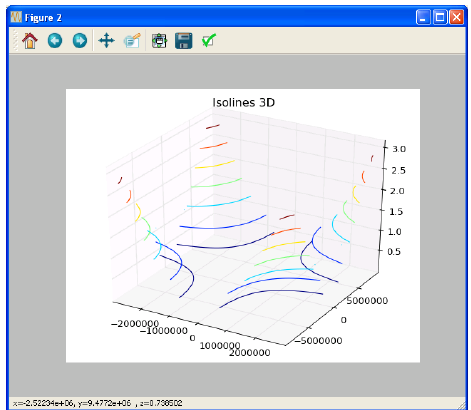
Fig. 17. The three-dimensional isolines generated by the developed